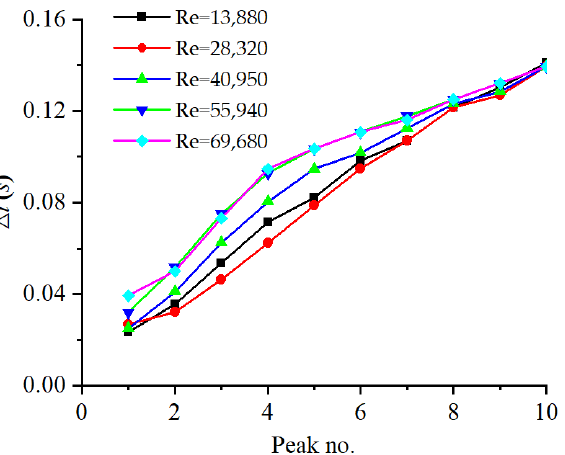
Figure 5. The time difference between the extreme value of retarded strain and instantaneous strain.